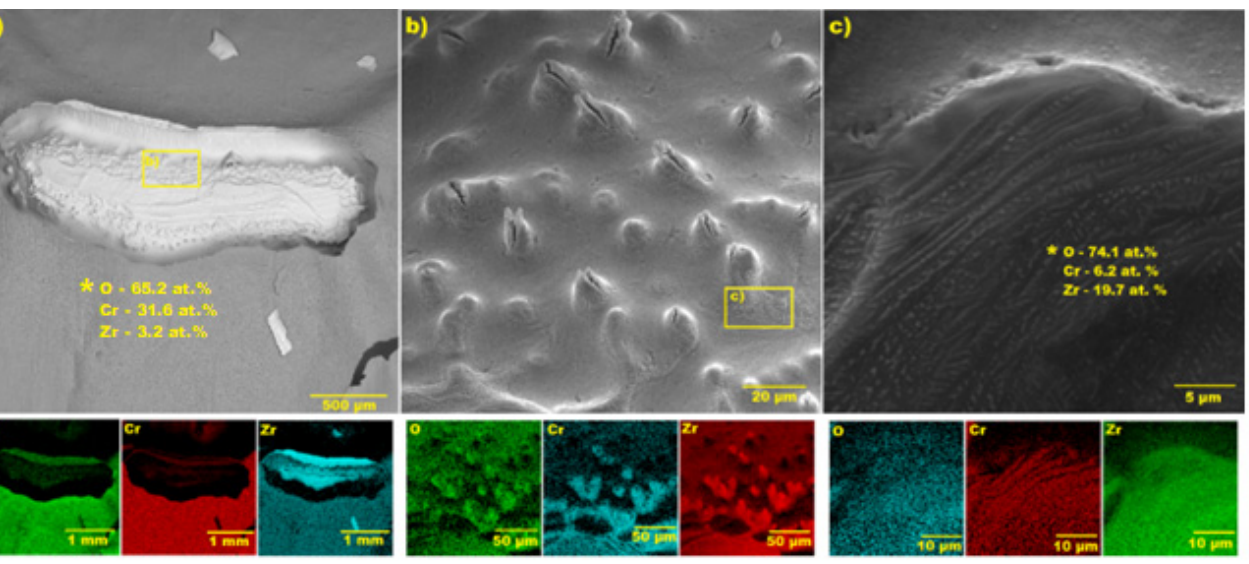
Figure 14. SEM images of the ZrO 2 /Cr-100 sample after oxidation in water steam at 1400 °C for 120 s and the corresponding EDS maps of Cr, Zr, and O of the sample at different magnification: ( a )— ×100; ( b )—×2000; ( c )—×8000. Points (*) indicate the positions of EDS measurements.